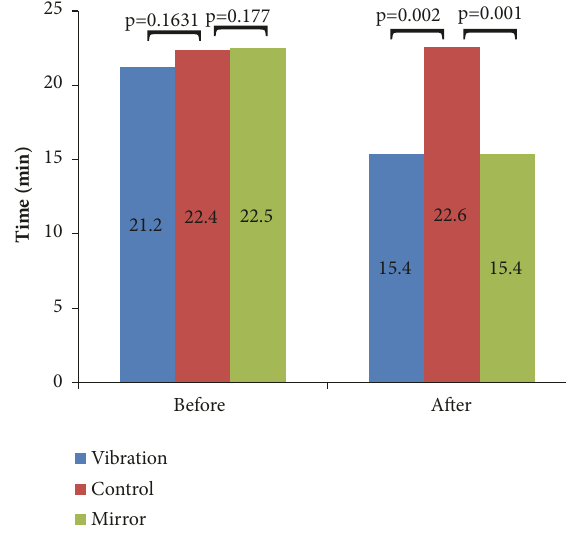
Figure 3: Data of the motor function (time) among the individuals of the control group, vibration and mirror therapy before and after the